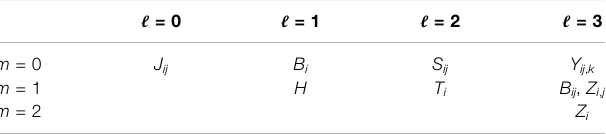
TABLE 1 | The fi rst few levels of the free Lie algebra generated by the (magnetic) Galileanchoice( Eq.2.36 ).Thedouble-grading( ℓ , m )isexplained inthetext. A similar table has appeared in Ref. 16.